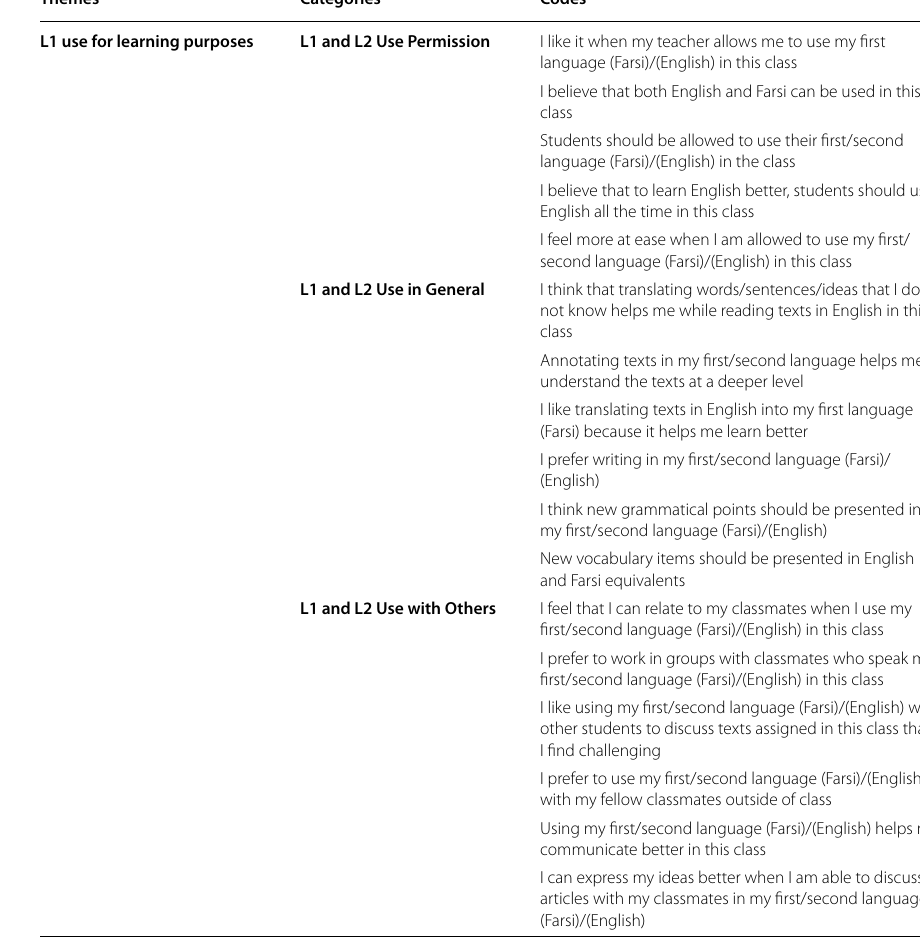
Table 1 The extracted codes, categories, and themes for the role of L1 and L2 using the constant comparison analysis